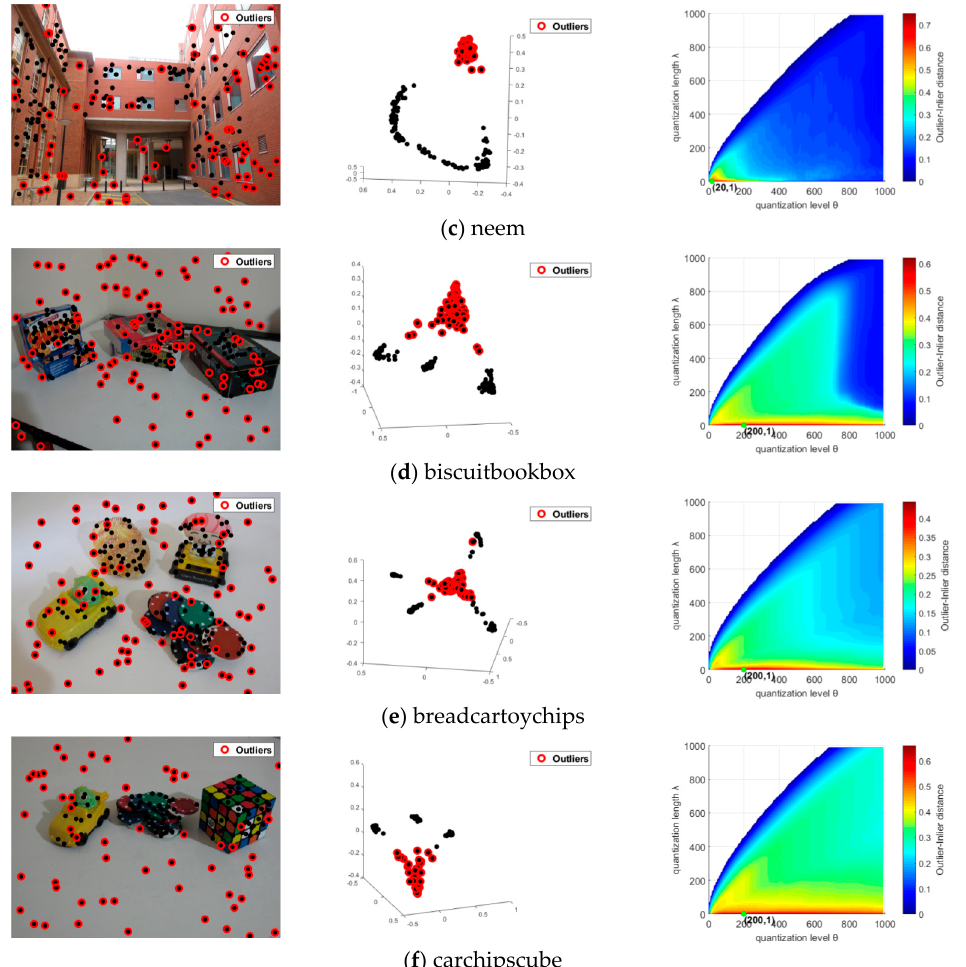
Figure 10. The impact of the quantization level and quantization length on the outlier detection.